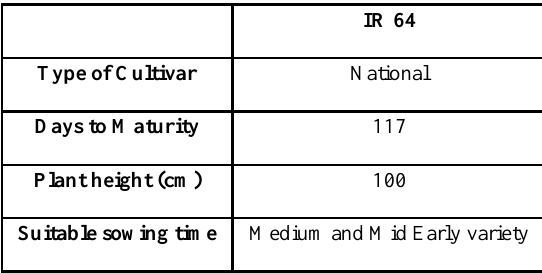
Figure 2: Characteristics of Selected Cultivar